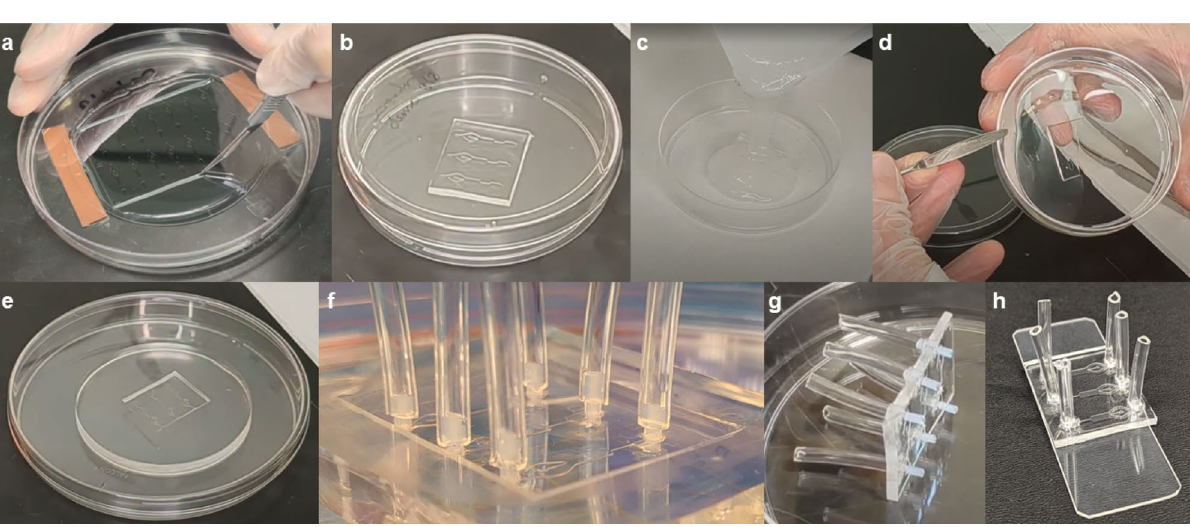
Figure 2. Example images of protocol stages. From left to right and top to bottom: ( a ) cutting PDMS from SU-8 wafer, ( b ) PDMS replica in the petri dish facing up, ( c ) pouring PDMS over replica, ( d ) releasing the PDMS mold from the replica, ( e ) the final PDMS mold without the replica device, ( f ) PDMS mold with tubing with no epoxy, ( g ) epoxy device taken out of mold after 24 h with PFTE rods still attached sitting on its side, and ( h ) the final epoxy device bonded to a glass